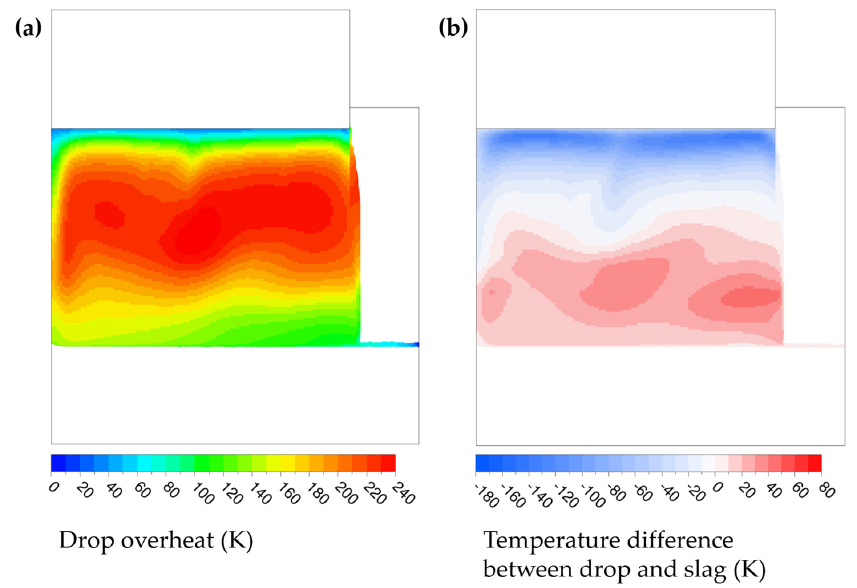
Figure 8. Drop overheat ( a ) and temperature difference between the drops and the slag ( b ) (time-averaged) for the 5 mm falling drops.